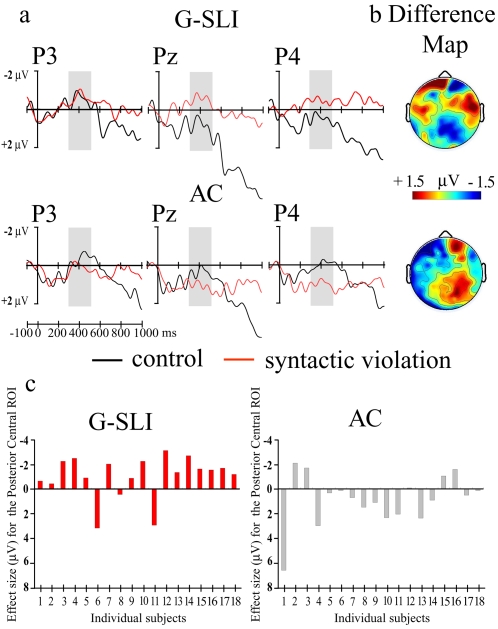
Semantic component (N400, 300–500 ms –grey area) elicited for the syntactic violation for the G-SLI group.
a. ERPs from three posterior electrodes (P3, left P4 right hemisphere and Pz midline) for the G-SLI and Age Control groups. b. Scalp distribution of the differences between the violation minus control sentences. The ERPs from the G-SLI participants elicited a negativity distributed on the posterior area for the syntactic violation (Condition×Caudality: F
2,34 = 3.08, p<.05). Note the raw data suggested a lateralisation of the N400 (Condition×Caudality×Laterality F
2,34 = 3.75, p = .03) whereas the normalised data indicated a non significant interaction (F
2,34 = 1.93, p = .15). No other group showed this result for the 300–500 ms time window. c. Effect sizes for individual G-SLI children and their age controls. Effect size: mean amplitude difference (violation minus control) in the Posterior Central ROI within the 300–500 ms temporal window. We plot Negativity upward.